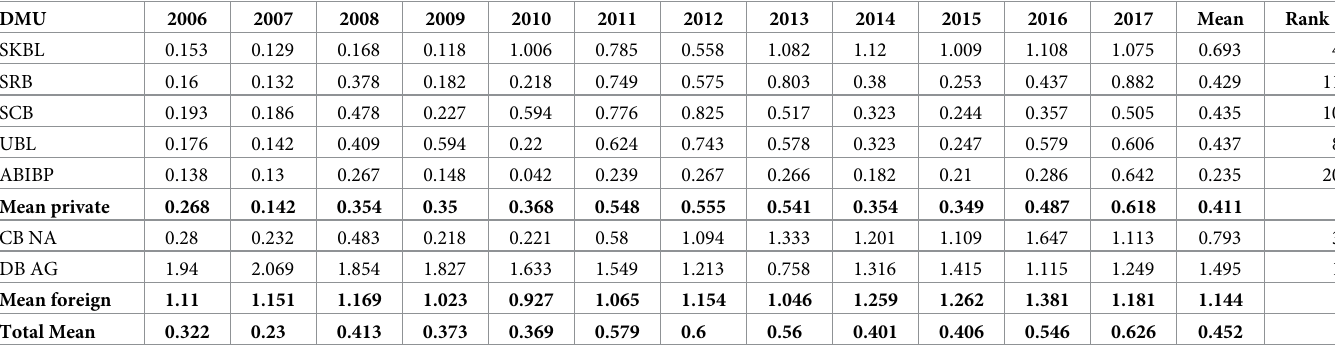
Table 7. Banking efficiency has been measured in two ways using different measures as men- tioned in section (2). Model (1) showed that bank size positively contributes to increasing